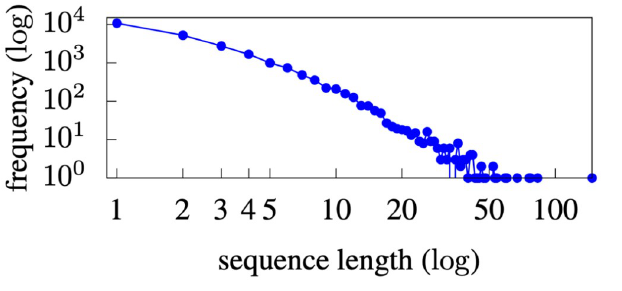
Fig 2. Distribution of INPC sequence length.